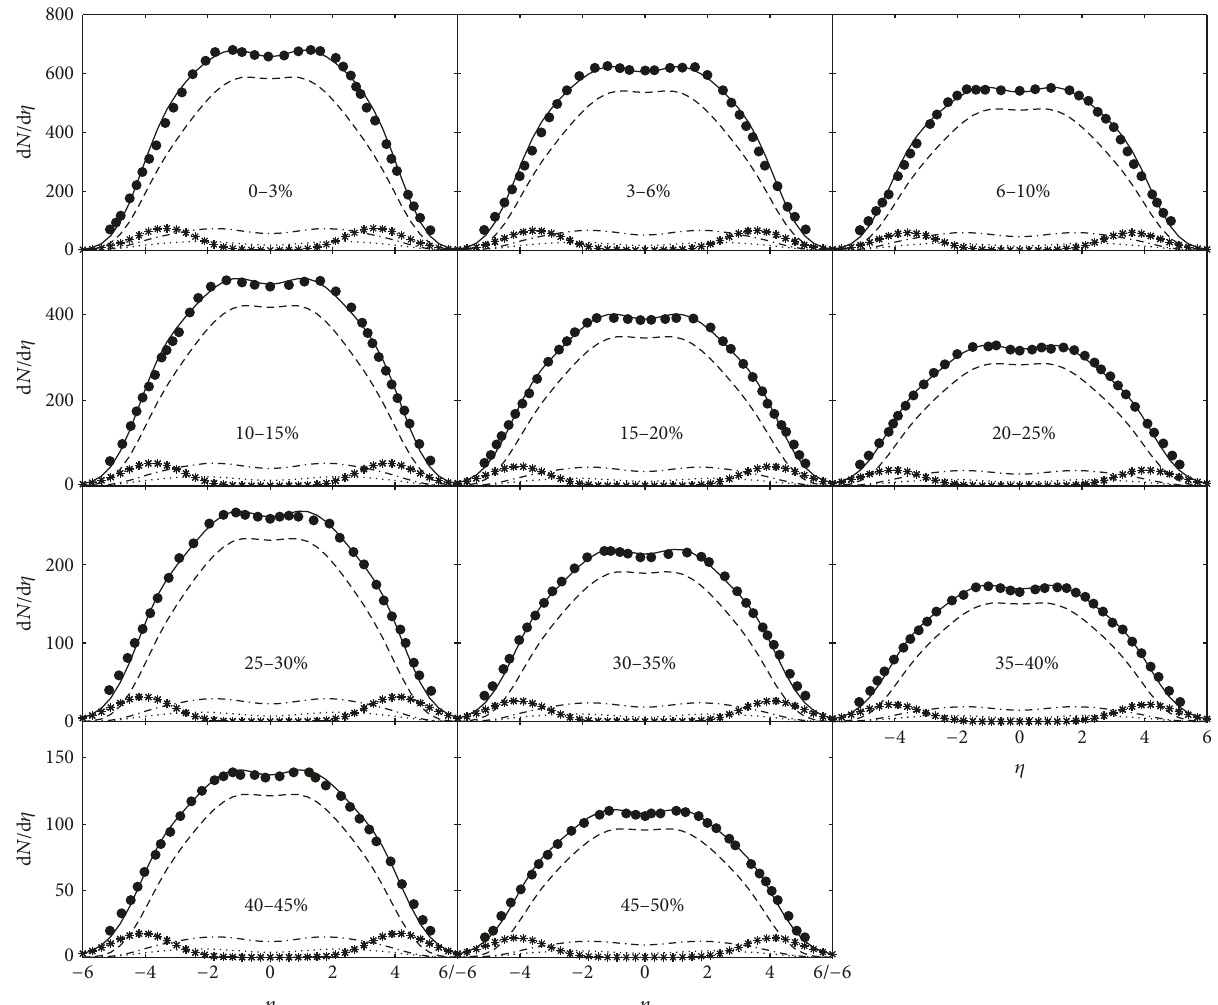
Figure 1: The pseudorapidity distributions of charged particles produced in different centrality Au+Au collisions at √𝑠 NN = 200 GeV. The solid dots are the experimental measurements [5]. The dashed, dashed-dotted, and dotted curves are, respectively, the contribution from pions, kaons, and protons got from the hydrodynamic result of (18). The dotted-star curves are the components of leading particles obtained from (23). The solid curves are the sums of the four types of